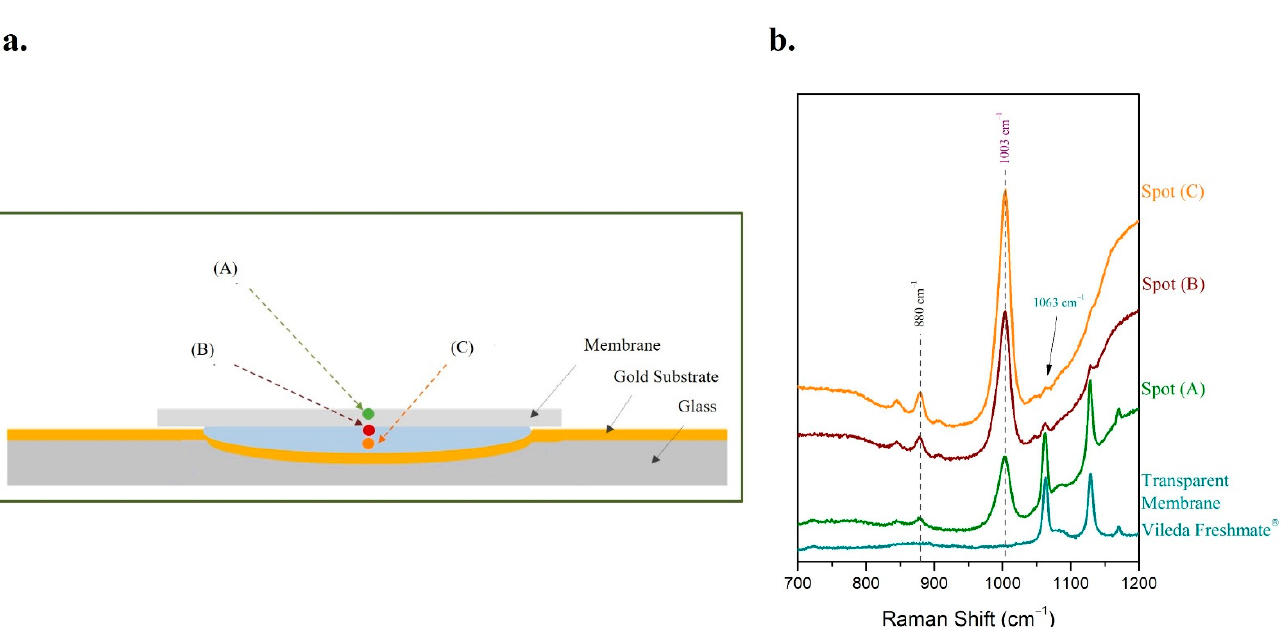
Figure 9. The method of placing the sample droplet in a cavity of a home-designed glass microscope slide coated with a gold highly reflective substrate and covering the sample with a piece of transparent cling film (Vileda Freshmate ® ) was applied for the determination of 5 µ L/mL ethanol in human urine. ( a ) Schematic illustration of the focus on three different spots of the sample in the cavity; ( b ) the respective Raman spectra from the three different spots of the sample in the cavity were recorded.